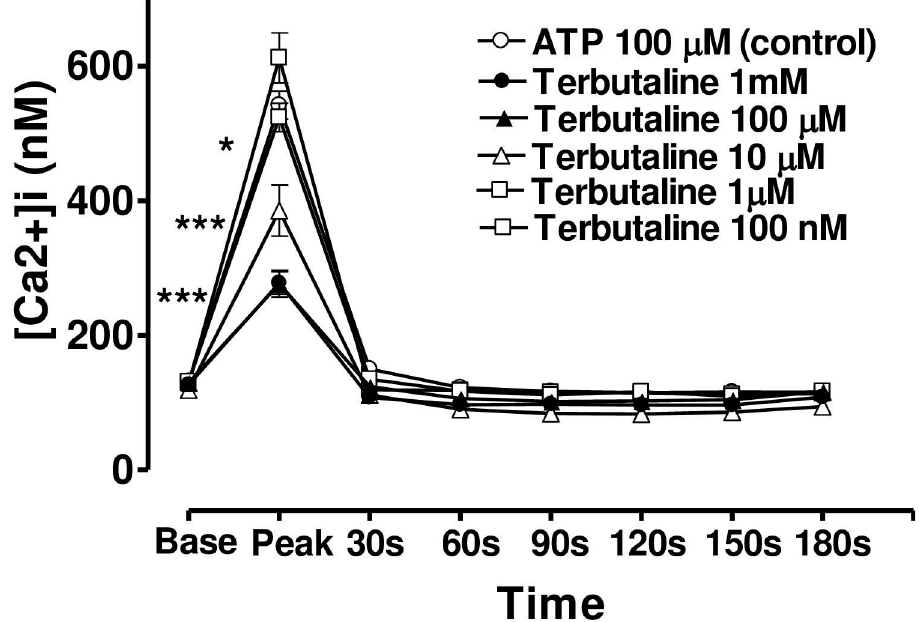
Fig 10. Effect of increasing concentration of terbutaline on the Ca 2+ -mobilizing response of ATP (100 μ M) in bovine cultured CE, in the absence of extracellular calcium. Terbutaline’s effect on both the peak Ca 2+ transient and at selected time intervals thereafter had been shown. Cultured cells were incubated for 6 min with appropriate concentration of terbutaline in HEPES buffered Krebs’ solution containing 40mM EGTA and no calcium. The cells were then exposed to 100 μ M of ATP. Each point represents a mean ± s.e.mean of 6–11 experiments. Significance of differences between incubations with or without terbutaline; �� p < 0.01 and ��� p < 0.001, Bonferroni’s multiple comparison test. Base value indicates the [Ca 2+ ] i prior to addition of